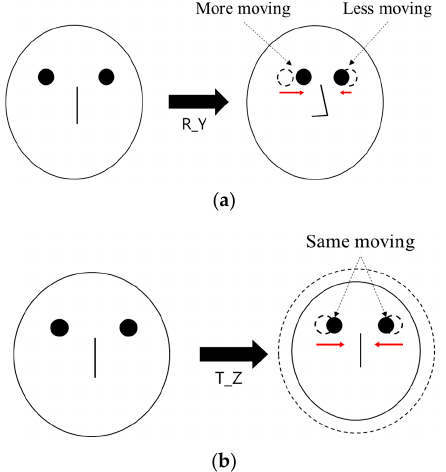
Figure 8. Difference of the movement of both eyes on horizontal axis in case of ( a ) R_Y movement ( b ) T_Z movement.